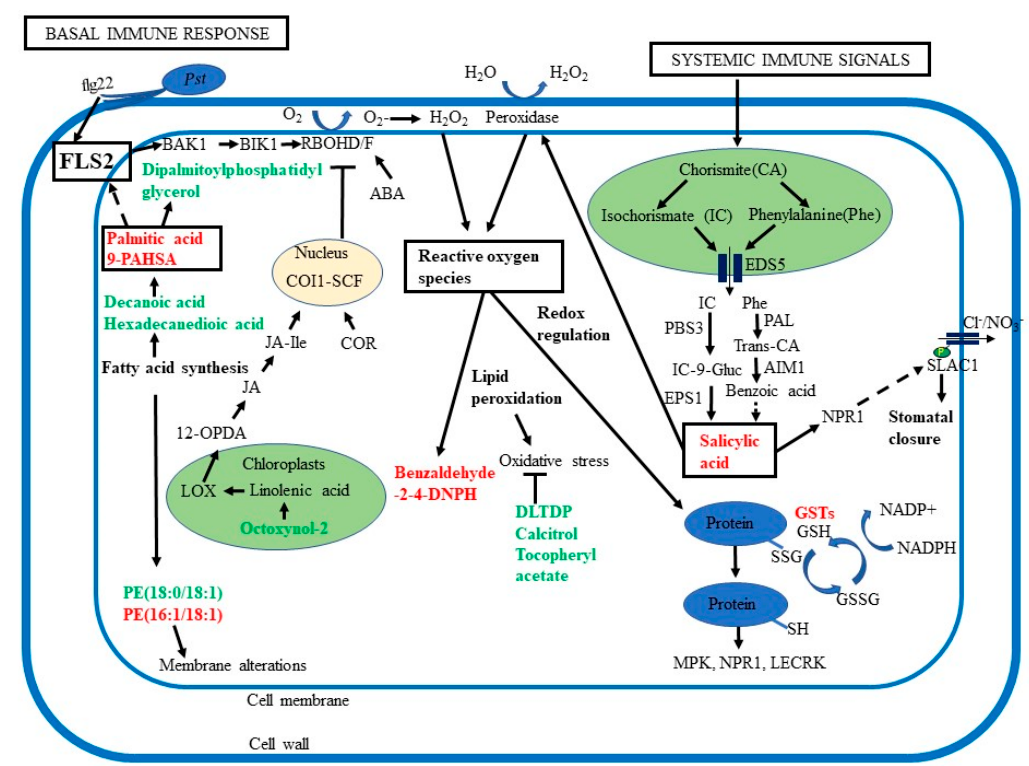
Figure 6. Overview of the roles of ROS, lipid signaling, and phytohormones in guard cell SAR. Guard cell SAR overlaps with basal immune response, which involves recognition of pathogen-associated molecular patterns (PAMPs) by receptors such as flagellin-sensing 2 (FLS2) and brassinosteroid insensitive 1-associated kinase 1 (BAK1), activation of Botrytis-induced kinase 1 (BIK1). BIK1 then activates respiratory burst oxidase homologs (RBOH) D/F to generate ROS. Palmitic acid, an activator for Toll-like receptors TLR 2 and 4, may also activate FLS2. Additionally, systemic immune signals activate biosynthesis of salicylic acid (SA), promoting H 2 O 2 production via peroxidases. SA biosynthesis starts in the plastids and pathway intermediates are transported by enhanced disease susceptibility 5 (EDS5) to the cytoplasm to produce SA. SA binds to its receptor non-expressor of pathogenesis-related (NPR1), a key regulator of SAR. Abscisic acid (ABA) can also activate RBOH, adding to ROS signaling. Ultimately, both SA and ABA act on membrane anion channels, driving water to move out and stomatal closure. Primed guard cells showed decreases in octoxynol-2, related to linolenic acid, an essential fatty acid found in chloroplasts, from which 12-oxophytodienoic acid (12-OPDA), a precursor for jasmonate (JA) is derived. JA is a precursor for jasmonic acid isoleucine (JA-Ile) which binds to coronatine-insensitive 1 (COI1) and the COI1/SCF complex blocks RBOH D/F generation of ROS. During pathogen-induced stomatal opening, the Pst toxin coronatine (COR) structurally mimics the JA-Ile and binds to COI1. COR also represses SA synthesis, leading to reopening of stomata. Intercellular accumulation of ROS leads to oxidative stress and membrane alterations. Oxidation of fatty acids and lipids helps to reduce oxidative stress. Cellular redox perturbation regulates key signaling proteins including mitogen-activated protein kinases (MPKs), NPR1, and lectin receptor kinases (LECRK). Glutathione (GSH) is important for the glutathione redox cycle and detoxification involves GSH peroxidase, GSH reductase, and glutathione S-transferases